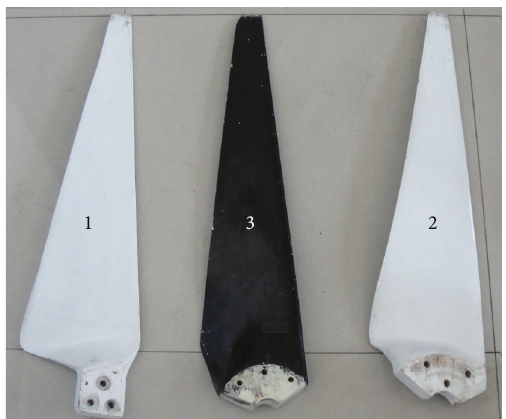
Figure 1: Three considered blade types.